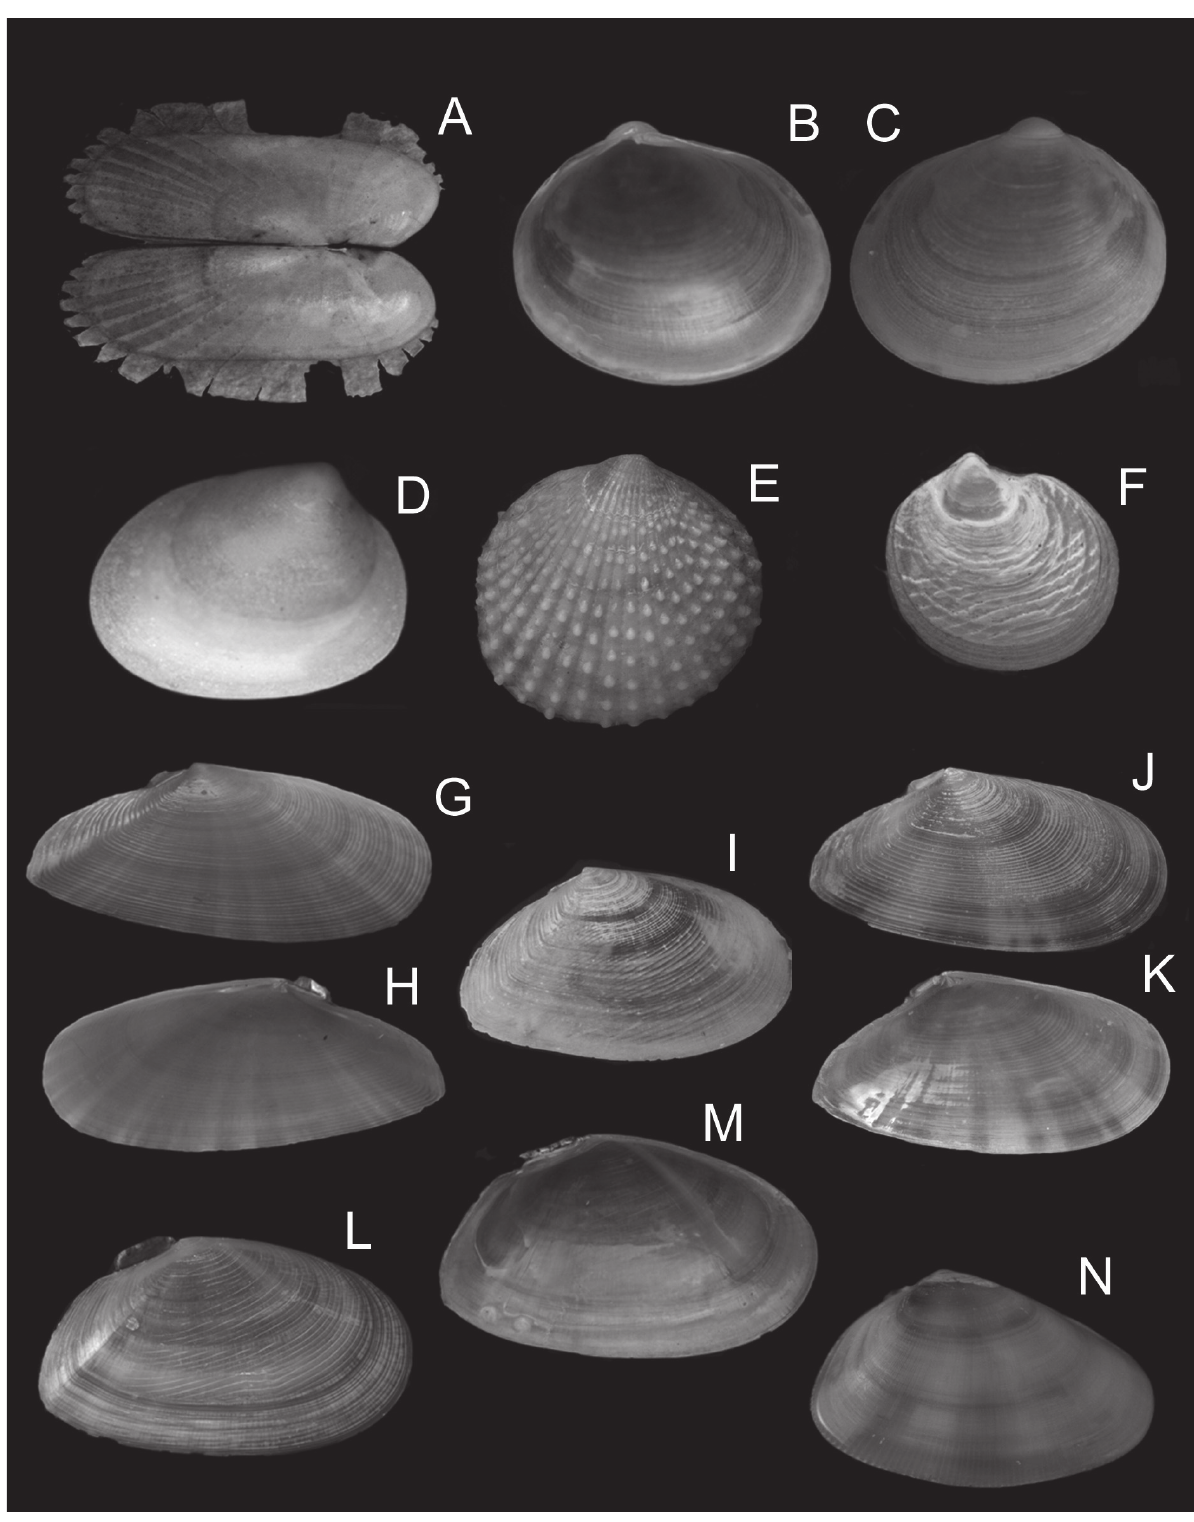
Fig . 6. – infaunal bivalves of Zostera marina . a, outside view of Solemya togata (shell length: 6.3 mm); B,C, inside and outside view of left valve of Scacchia oblonga (2.9 mm); d, outside view of left valve of Kurtiella bidentata (1.7 mm); e, outside view of right valve of Papil- licardium papillosum (5 mm); f, outside view of right valve of Lucinella divaricata (1.6 mm); g, H, outside and inside views of right valve of Tellina pulchella (15 mm); i, outside view of right valve of T. fabula (8.5 mm); J, K, outside view of right valve and inside view of left valve of T. distorta (7.5 mm); L, m, outside view of right valve and inside view of left valve of T. compressa (19 mm); n, outside view of right valve of a juvenile of Donax venustus (4